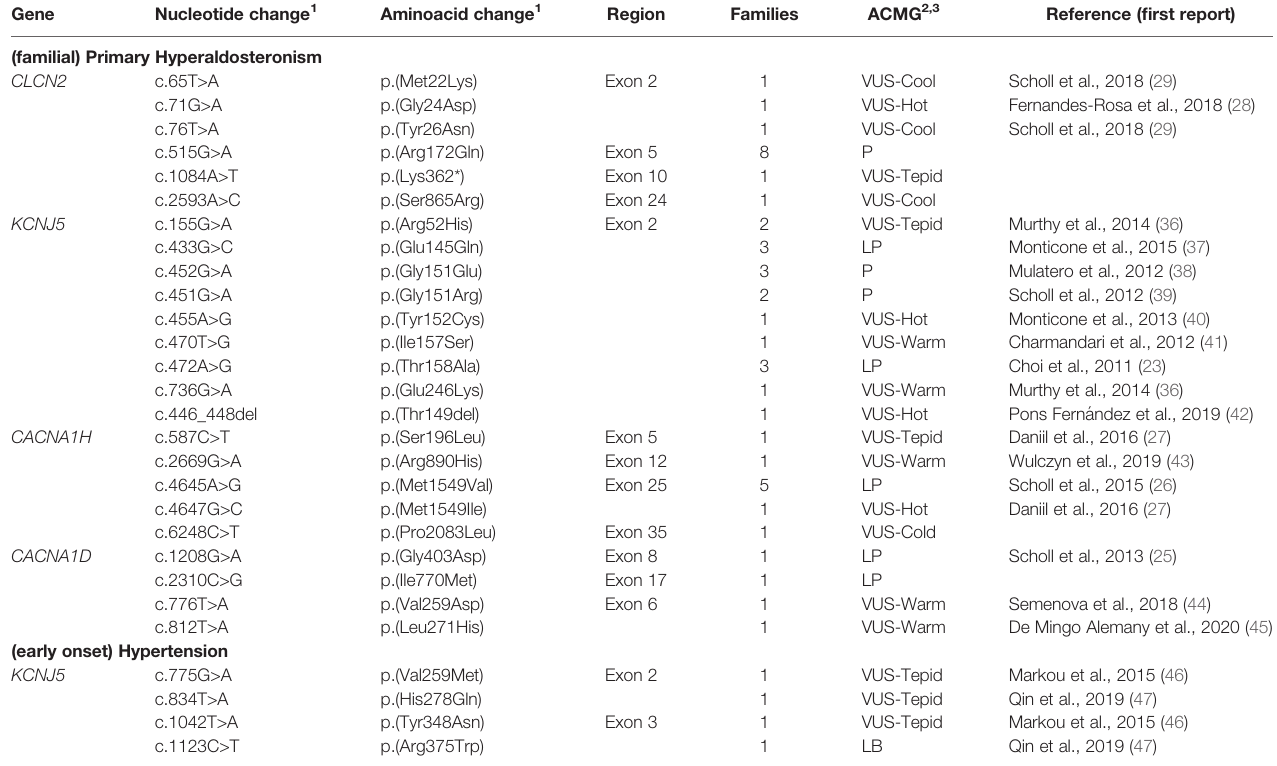
TABLE 2 | Germline allelic variants identi fi ed in probands with (familial) primary hyperaldosteronism/(early onset) hypertension. Gene Nucleotide change 1